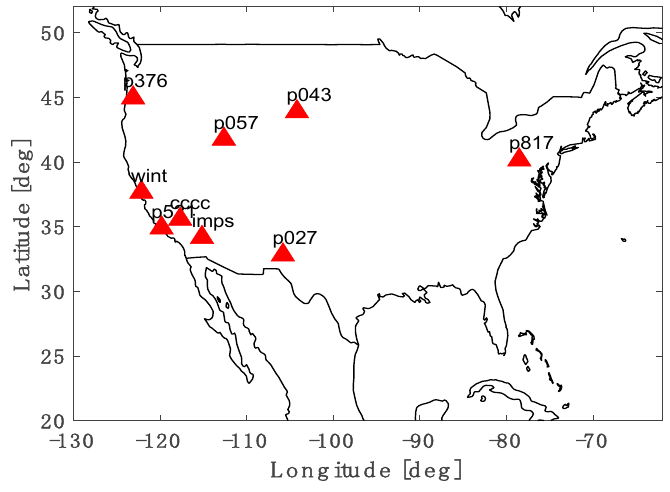
Figure 15. GNSS reference site distribution.